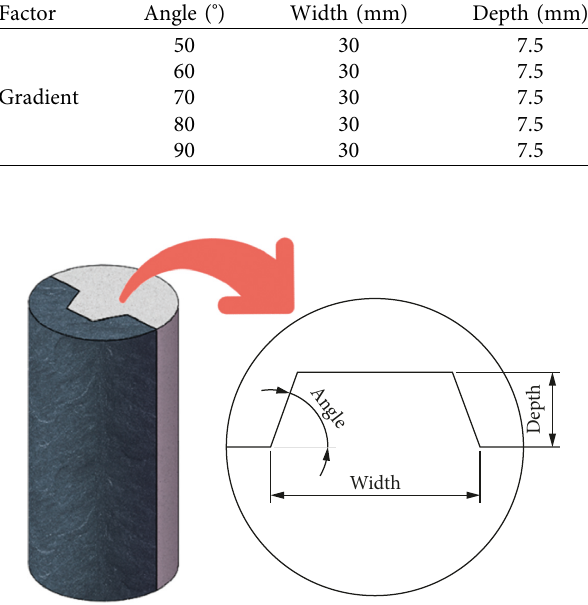
Figure 4: Structure of the coal pillars-artificial